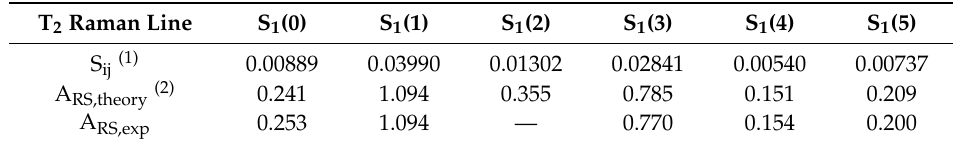
Table 4. Comparison of the Raman line strengths Sij, and the experimental and theoretical signal amplitudes—A RS,theory and A RS,exp , respectively—for the T 2 S 1 ( J ”) Raman lines of Figure 5. T 2 Raman